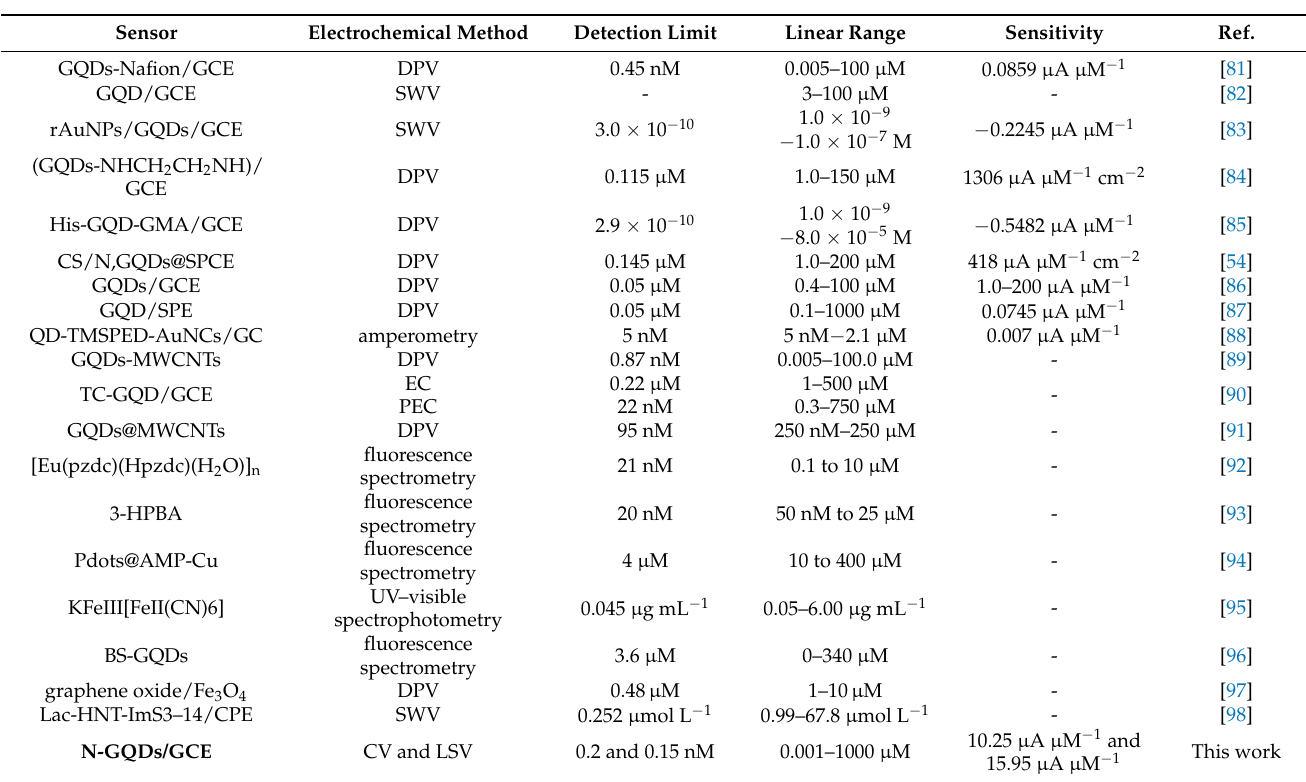
Table 1. The performance comparison of N-GQDs/GCE with previously reported DA electrochemi- cal